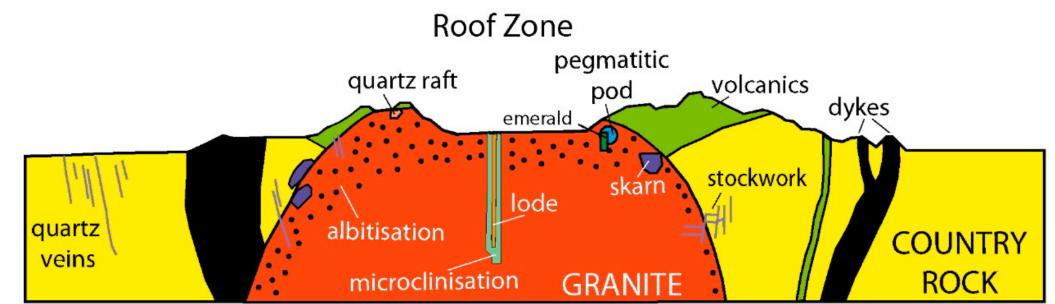
Figure 20. Ring complexes of Nigeria and emerald mineralization. Idealized cross-section showing structural setting and styles of